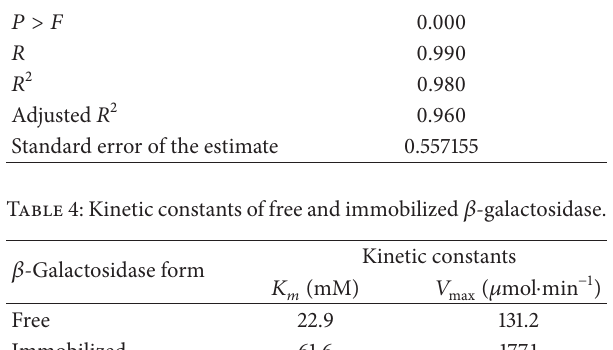
Figure 7: Reusability of immobilized 𝛽 -galactosidase. Table 3: ANOVA test for the experiment. Response 𝑌 of Beads Term 𝛽 -galactosidase activity (U/g beads) 48.945